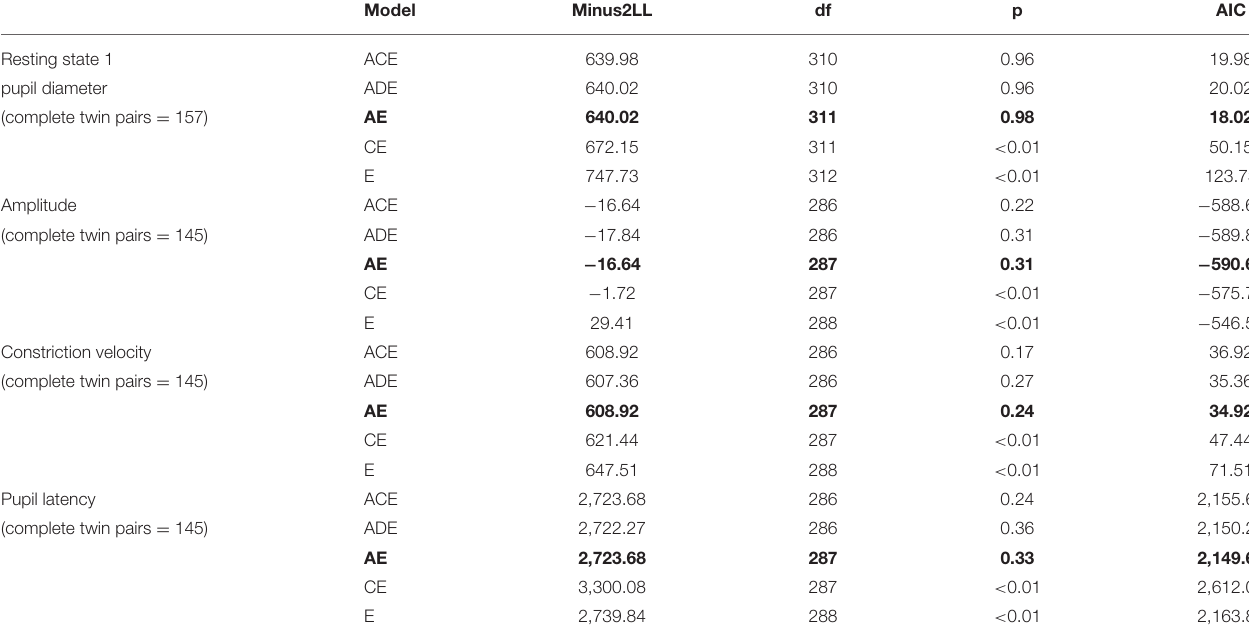
TABLE 4 | Results of twin model fitting for left eye only.